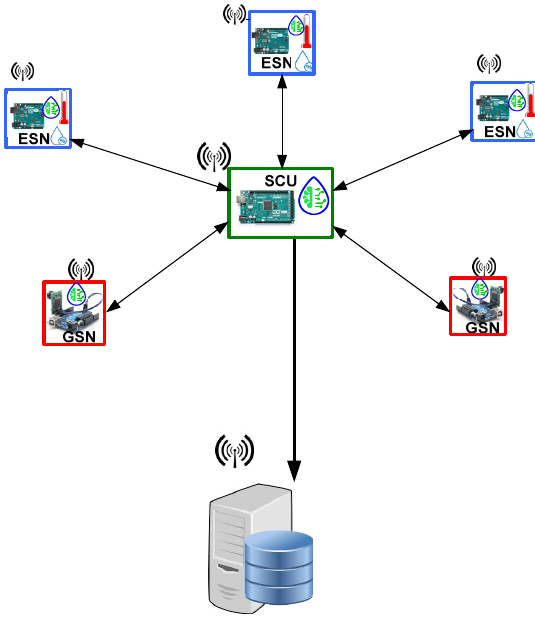
Figure 2. iPONICS WSN topology.